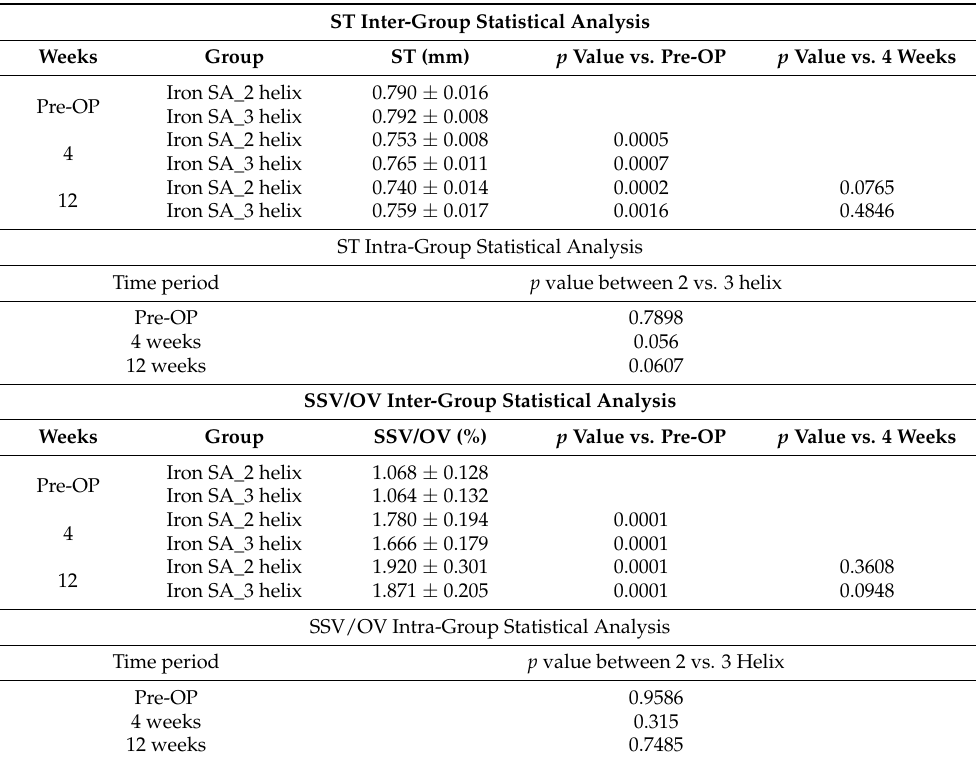
Table 5. Micro-CT degradation analysis of the iron suture anchor for structure thickness (ST) and